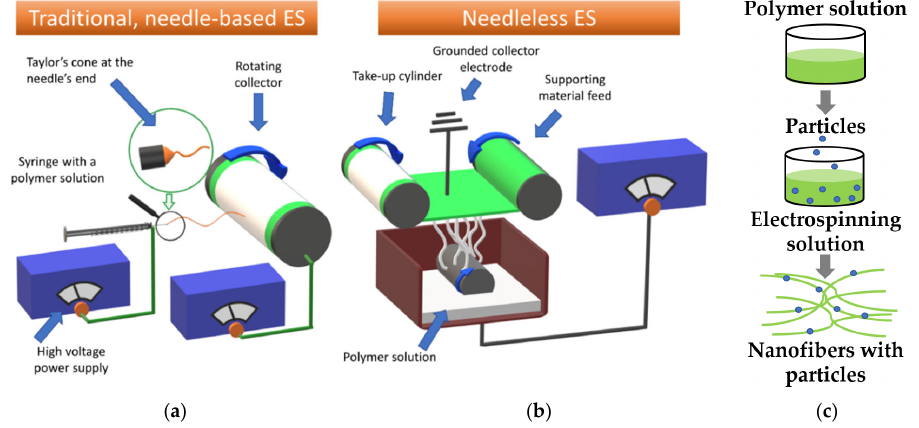
Figure 1. ( a ) Needle ‐ based and ( b ) needleless electrospinning (ES) techniques. Reprinted from study [19], originally published under a CC ‐ BY 4.0 license; ( c ) Manufacturing process of nanofibers with